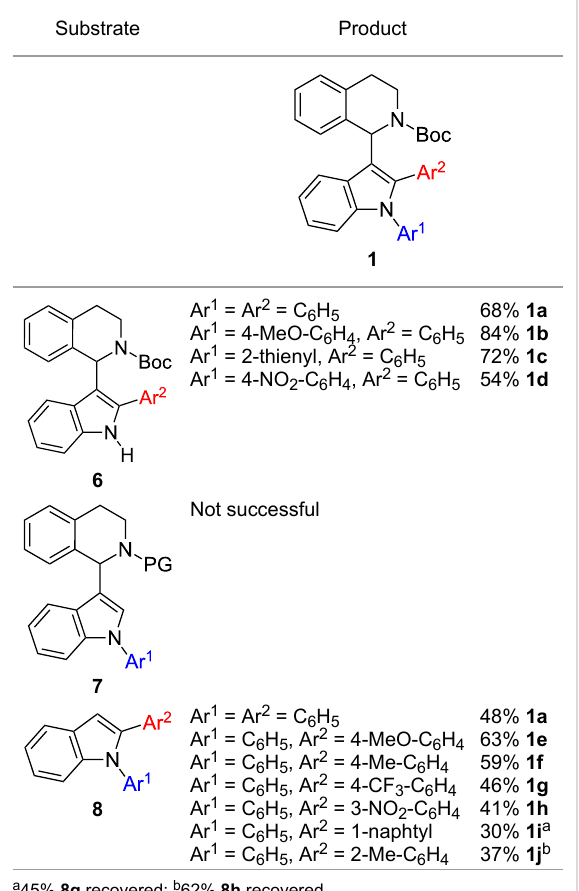
Table 10: Comparison of the final reaction step towards 1 starting from intermediates 6 – 8